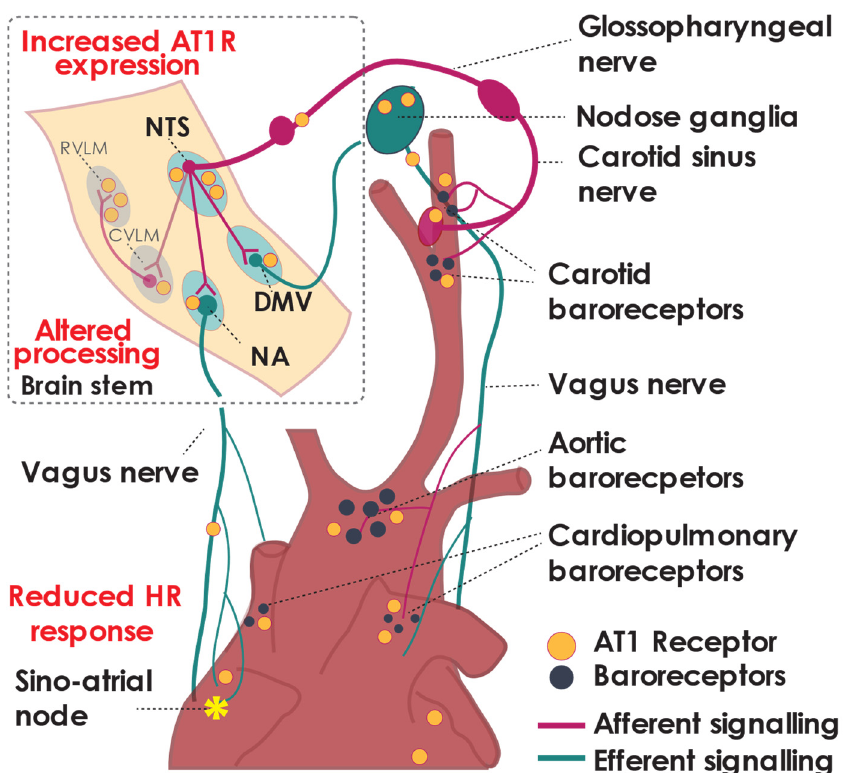
Figure 2. Baroreflex signally is altered in hypertension. Altered integration of the afferent baroreflex signal in the brain regions of the NTS and NA, affect heart rate response to baroreflex activation. NTS, nucleus tractus solitarii. DMV, dorsal motor nucleus of the vagus. NA, nucleus ambiguous. RVLM, rostral ventrolateral medulla. CVLM, caudal ventrolateral medulla.